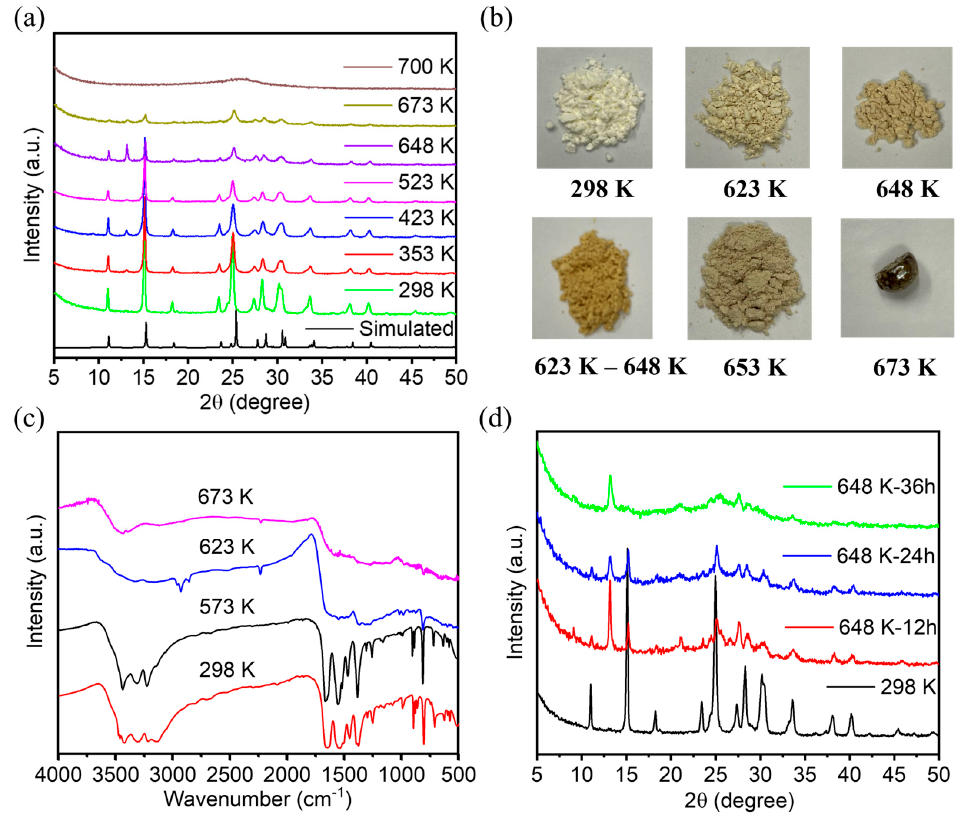
Figure 3. ( a ) VT-PXRD patterns of the crystalline of FDU − HOF − 1. ( b ) Photographs of FDU − HOF − 1 powder after being treated under different temperature conditions. ( c ) Stacked FIIR spectra of FDU-HOF-1 at different temperatures. ( d ) PXRD patterns of the FDU − HOF − 1 − 298 K and FDU − HOF − 1 − 648 K for different times.